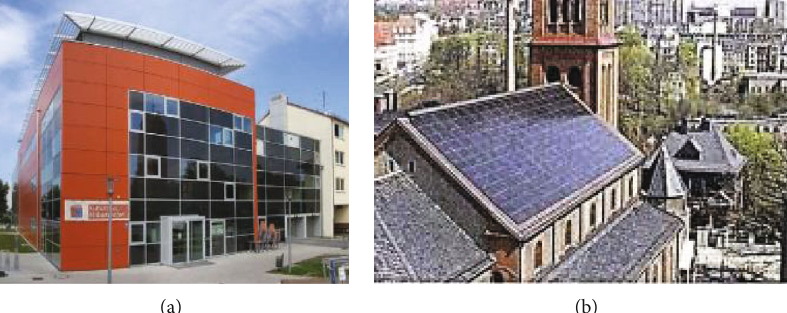
Figure 11: (a) Facade with black micromorph and semitransparent thin- fi lm modules in Germany and (b) rooftop application of opaque photovoltaic modules in the Netherlands. Sources: Bambara [71]; Kha [72].